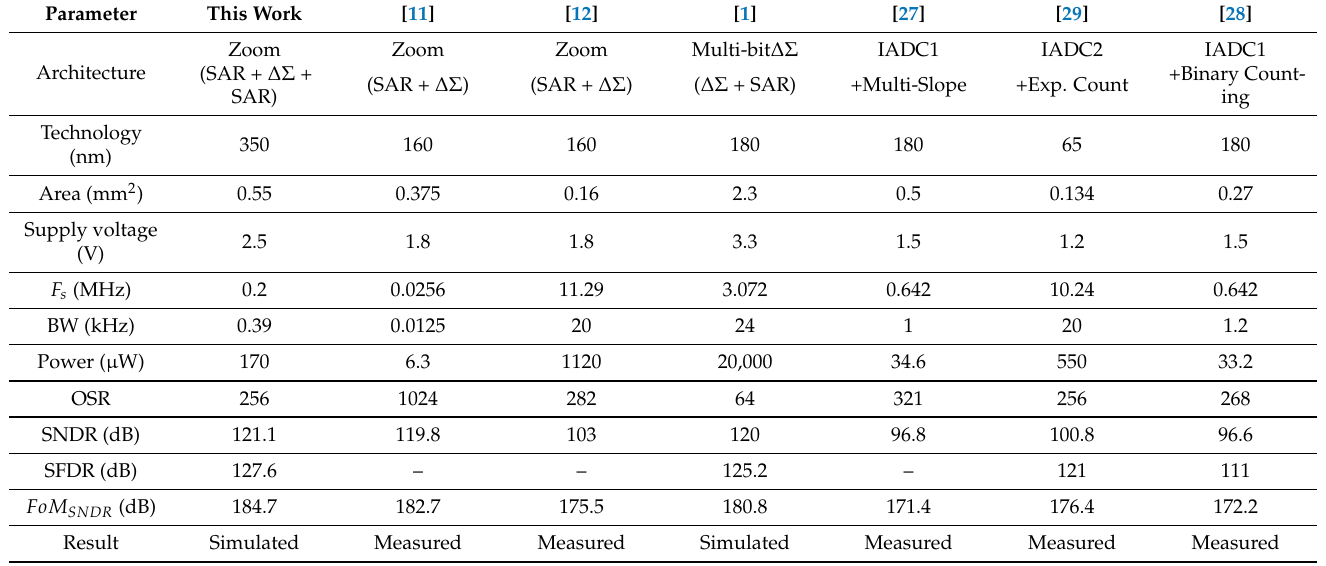
Table 2. Performance